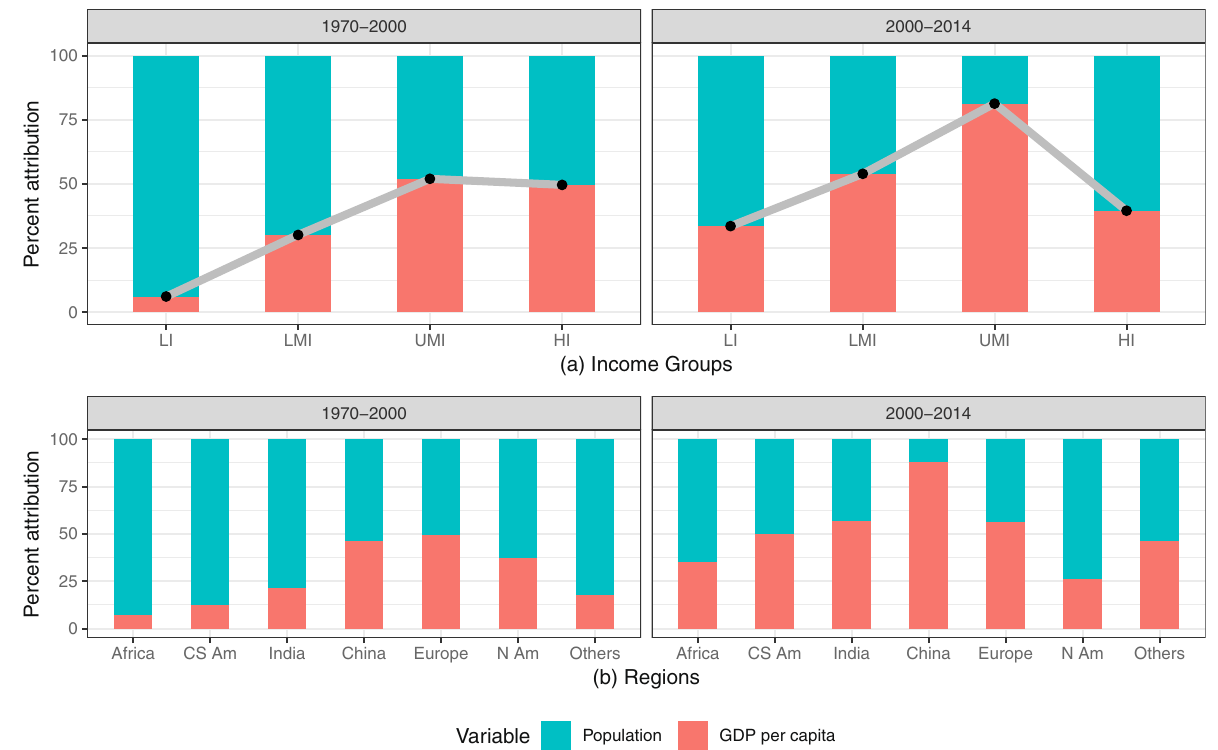
Fig. 2 Percentage of ULE explained by GDP per capita growth rate and population growth rate across income groupings and geography. a Country income categories, and b region groups in pre-2000 and